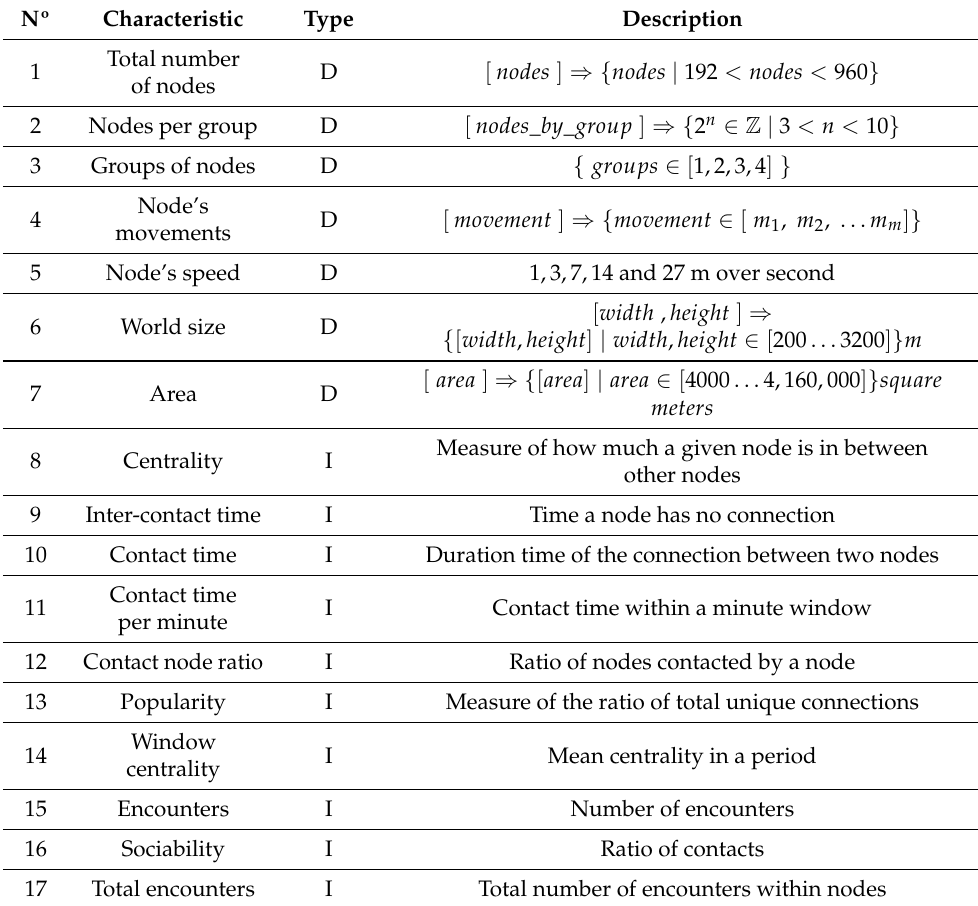
Table 1. Set of characteristics for a scenario definition, characteristics are classified as direct (D) and indirect